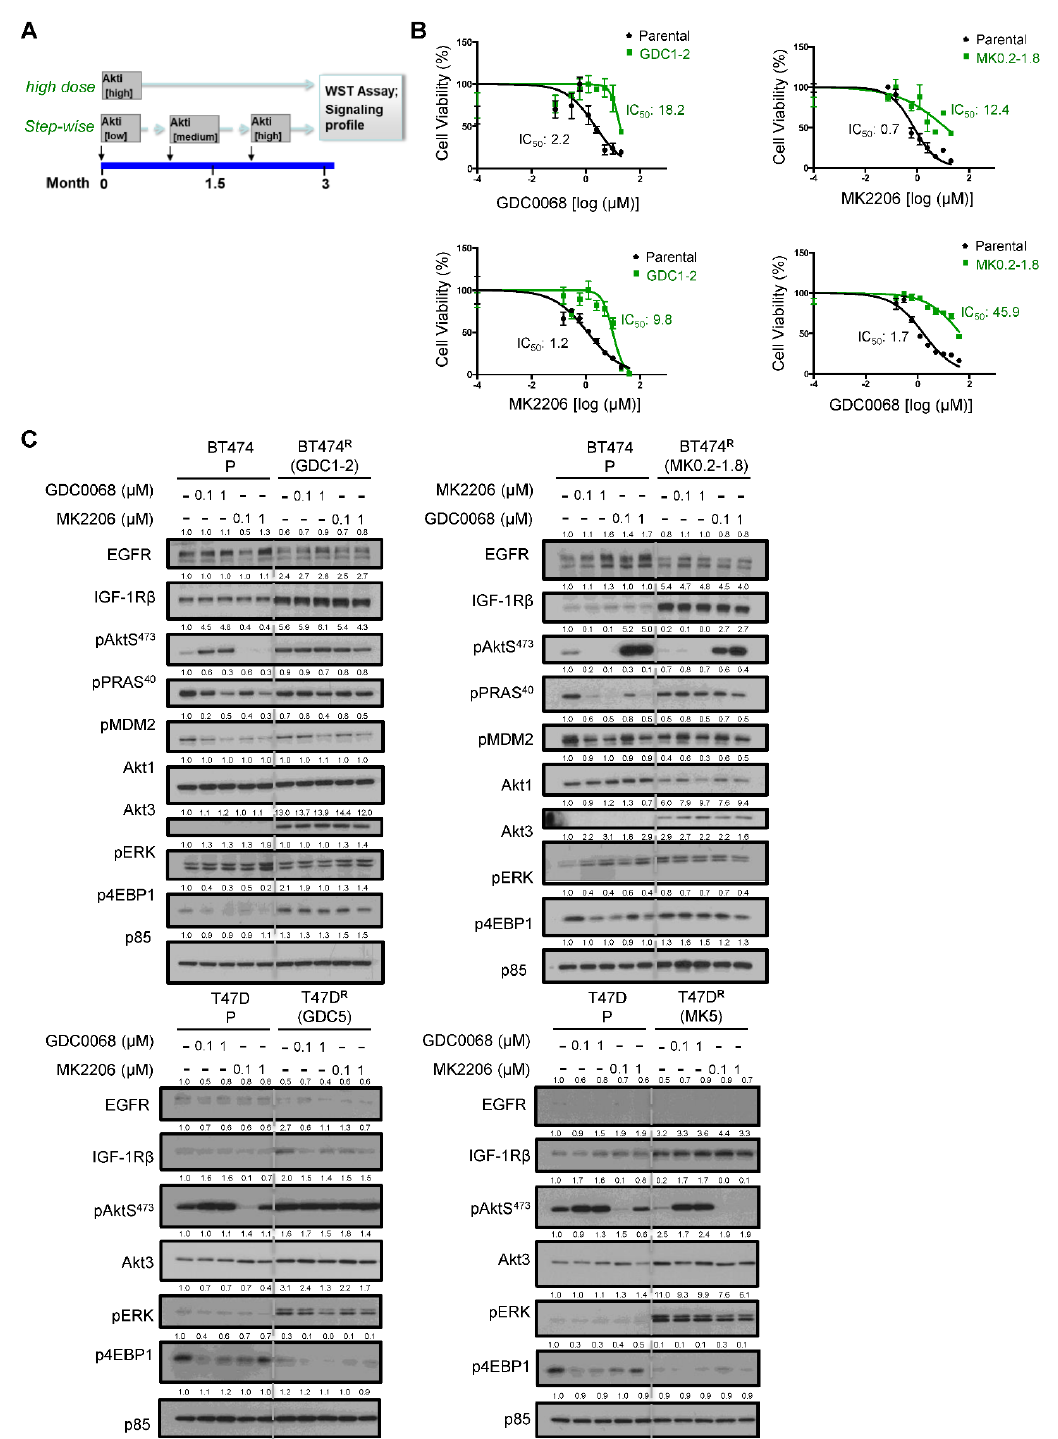
Figure 1. Establishment and characterization of breast tumor cell lines resistant to Akt inhibitors. ( A ) Schematics of establishing Akt-inhibitor-resistant lines using high dose or step-wise method. ( B )